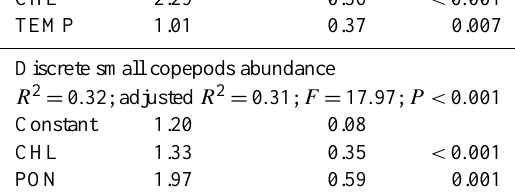
Fig. 8. Relationship between chlorophyll a concentration (µg L -1 ) and zooplankton abundance (a) (microscope counts) and net zooplankton biomass (b) across the whole Mediterranean Sea. For A, B and C stations, day sampling (d) and night sampling (n). See table 1 and figure 1 for localization of stations. Note: st 7 biomass value was removed from the analysis.